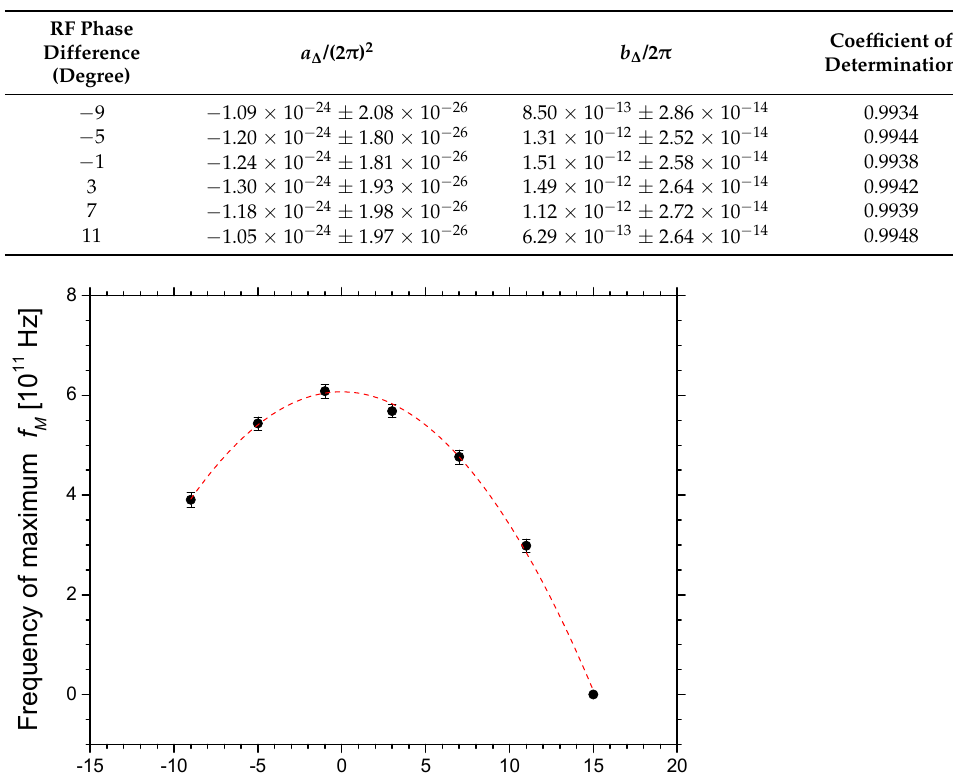
Figure 4. Relationship between the logarithm of ratio O ∆ / O +15 divided by angular frequency and the frequency. Table 1. Coefficients calculated by the least squares method for the measured spectra shown in Figure 3.